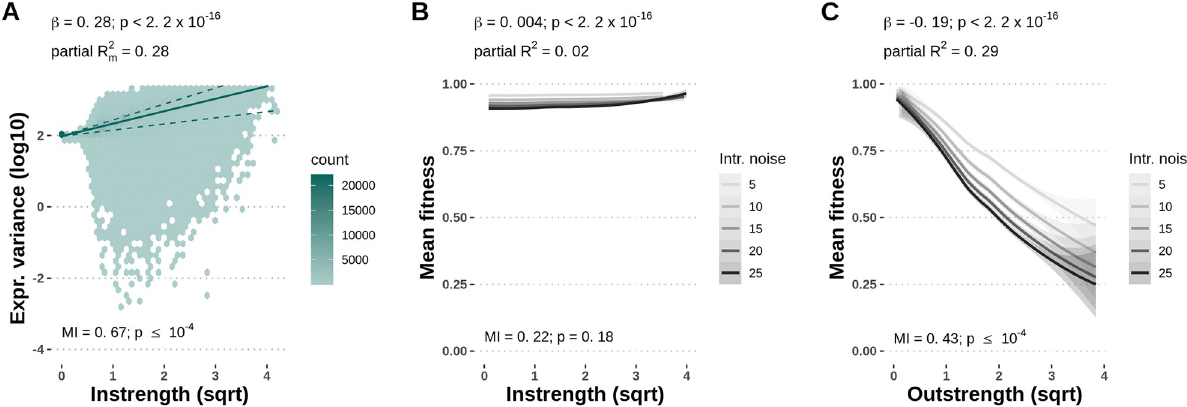
Fig 2. Noise propagation is captured by the gene regulatory network model. A —Gene-specific expression variance increases with the absolute instrength of the node, indicating noise propagation is reflected in the gene regulatory network model. The lines indicate the 25% (lower dashed line), 50% (solid line), and 75% (upper dashed line) fitted quantiles. B, C —Gene-specific expression variance decreases fitness in gene networks under stabilizing selection on gene expression level. Increasing the level of gene-specific expression noise reduces the mean fitness of the clonal population. The mean fitness of the population is significantly, but marginally, increased by noise in genes with higher node instrength (B), and significantly decreased by noise in genes with higher node outstrength (C). Lines represent the smoothed conditional means and grey bands represent the 95% confidence interval bands. Coefficients, p-values and partial marginal R 2 measures are estimated using linear mixed-effects models with expression variance or mean fitness as the response variable, instrength and outstrength as fixed effect explanatory variables, and the network topology sample as the random effect explanatory variable. Mutual information (MI) p-values were computed with a permutation test with 10,000 permutations.